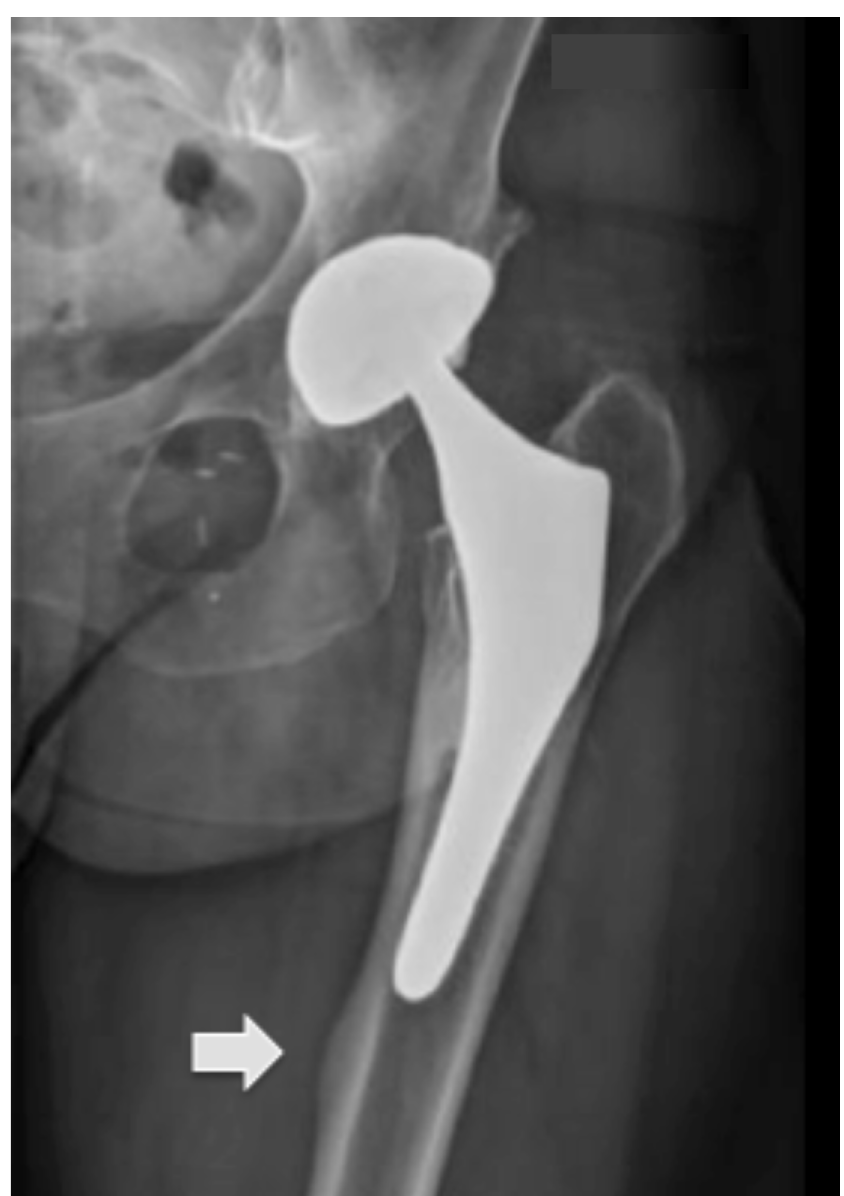
Figure 6. Cortical hypertrophy observed in zone 4. The white arrow shows stress shielding on the tip of the